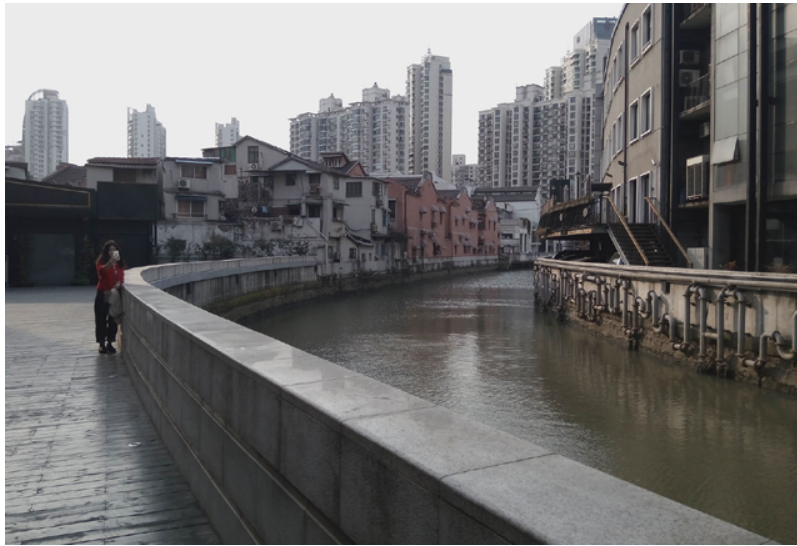
Most creeks disappeared and the few remaining ones, such as Hongkou Creek, are FIG. often disconnected from urban life by floodwalls (photo by author, 2018).